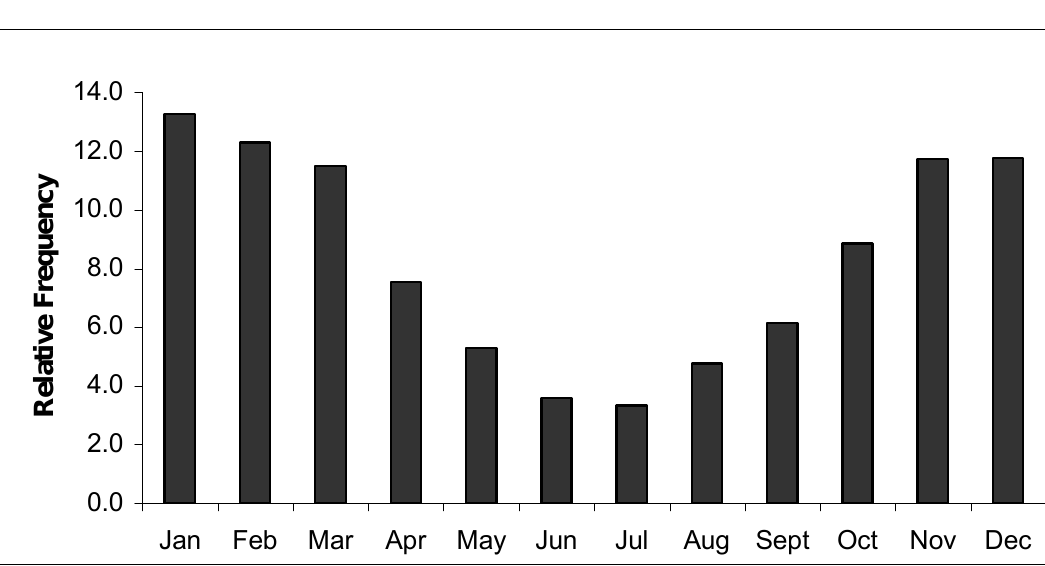
Figure 2: Frequency of Loxosceles spider bites (n=20,620) in the state of Paraná, 1993-2000.